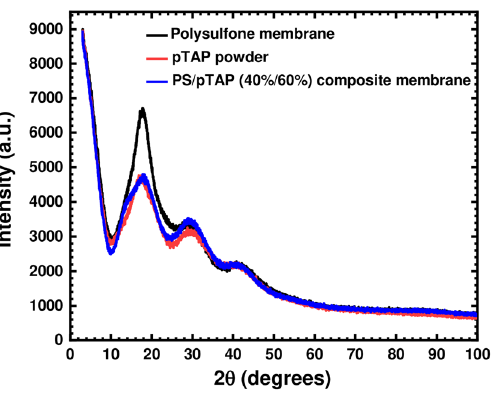
Figure 11. XRD spectra for polysulfone, pTAP polymer and the PS/pTAP composite